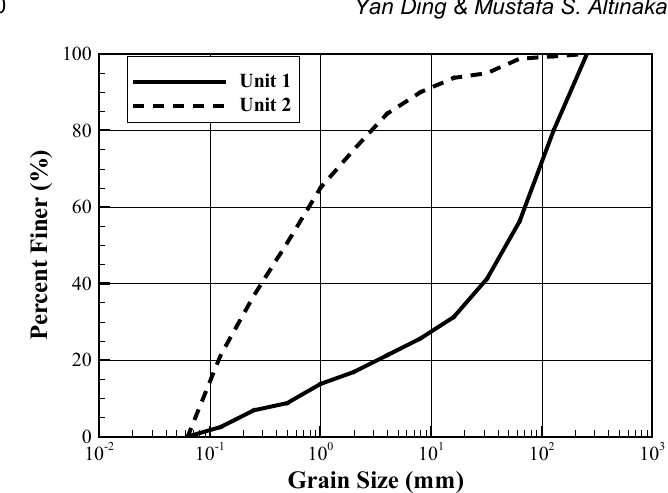
Fig. 2 Particle size distribution of the two uppermost sediment layers in the Marmot Dam.